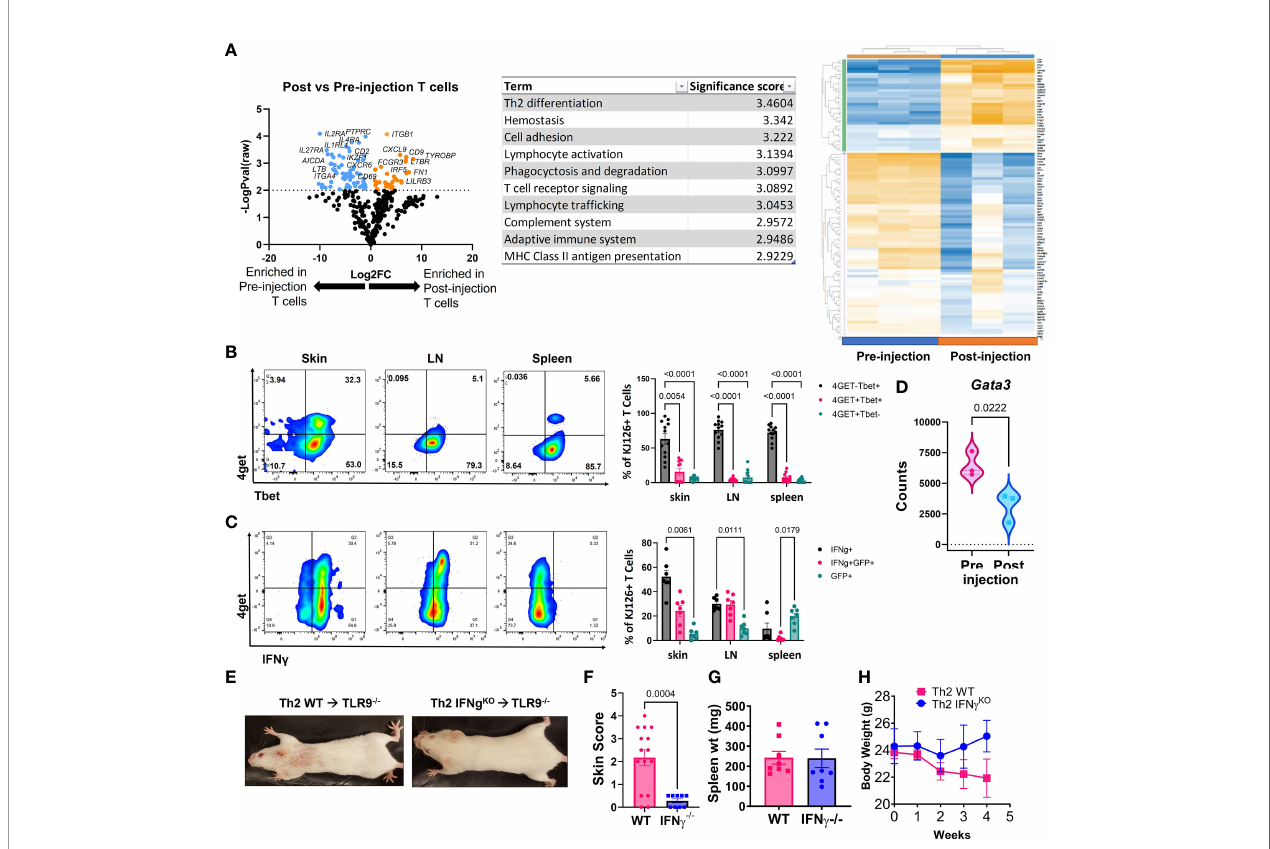
FIGURE 3 | Analysis of post-injection T cells reveals a Th1-shift, and IFN g is required for development of skin lesions. (A) NanoString analysis of post vs pre-injection T cells including volcano plot, GSA and heatmap generated with Rosalind software (n=3 pre-injection and n=3 post-injection enriched T cells pooled from 2 separate experiments). (B) Flow cytometry analysis of 4get reporter and Tbet expression in skin, lymph node (LN) and spleen of mice exhibits a Th1 switch post-injection (n=7 mice pooled from 2 separate experiments; two-way ANOVA with Tukey ’ s post-tests signi fi cant as indicated). (C) Flow cytometry analysis of 4get reporter and IFN g expression in skin, lymph node (LN) and spleen of mice exhibits a Th1 switch post-injection (n=12 mice pooled from 2 separate experiments; two-way ANOVA with Tukey ’ s post-tests signi fi cant as indicated). (D) Assessment of Gata3 RNA expression in pre- vs post-injection Th2 cells (n=3 pre-injection and n=3 post-injection T cells pooled from 2 separate experiments; one-tailed student ’ s t test signi fi cant as indicated). (E) Representative images of mice injected with Th2 skewed WT or IFN g -/- DO11 cells. (F) Skin disease scores, (G) spleen weights and (H) body weights of mice (n=15 WT and 9 IFN g -/- DO11 recipient mice pooled from 2 separate experiments, student ’ s t tests signi fi cant as